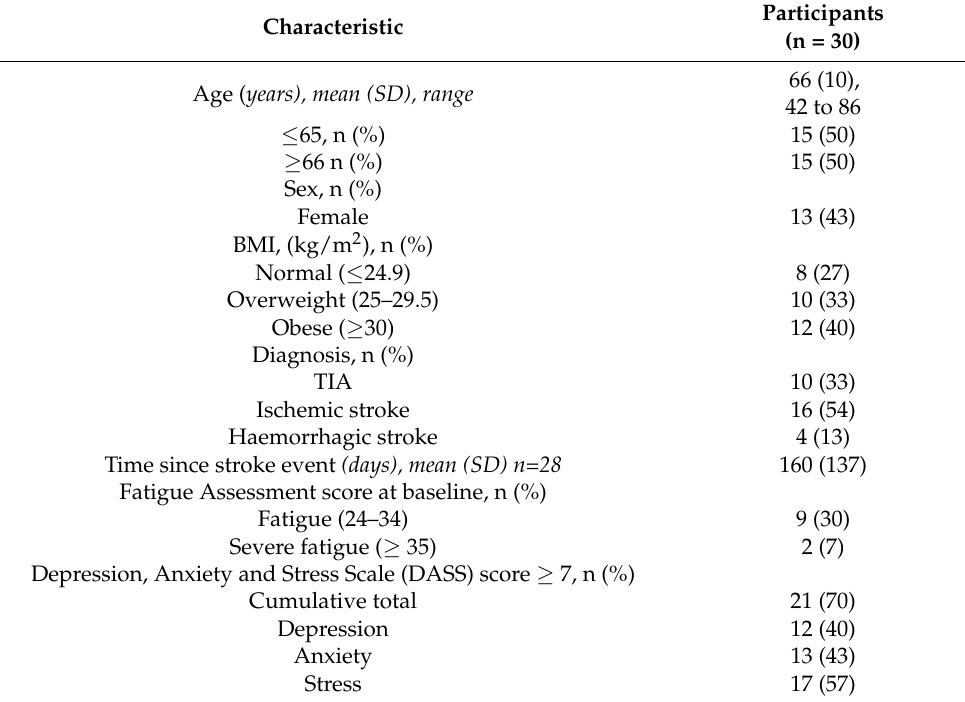
Table 1. Characteristics of 30 participants interviewed for qualitative study investigating experiences of participating in a secondary stroke prevention